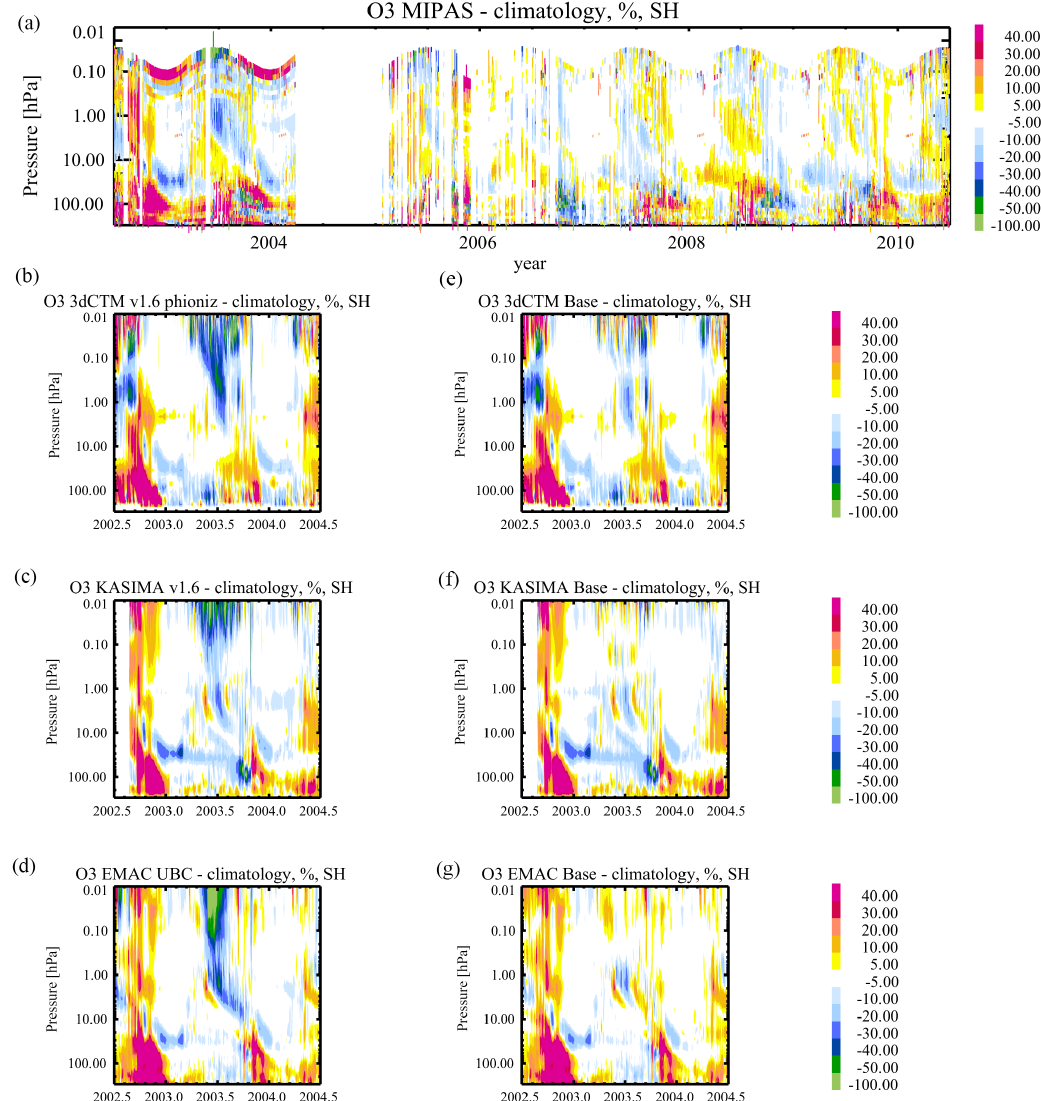
Figure 10. (a) Relative anomalies of MIPAS O 3 compared to a daily climatology derived from the 2006–2009 mean (%; see text) for high southern latitudes (70–90 ◦ S) for the period 2002–mid-2010. (b–g) Relative anomalies for the model results, calculated in the same way for mid-2002 to mid-2004. Left: model runs including particle impact; right: model runs without particle impacts. From top to bottom: 3dCTM, KASIMA and